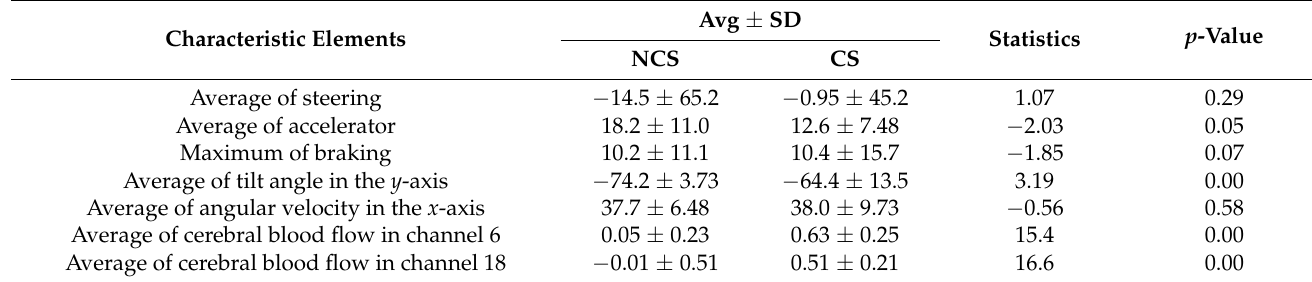
Table 8. Characteristics of behavior and cognition of older drivers when they feel calm.